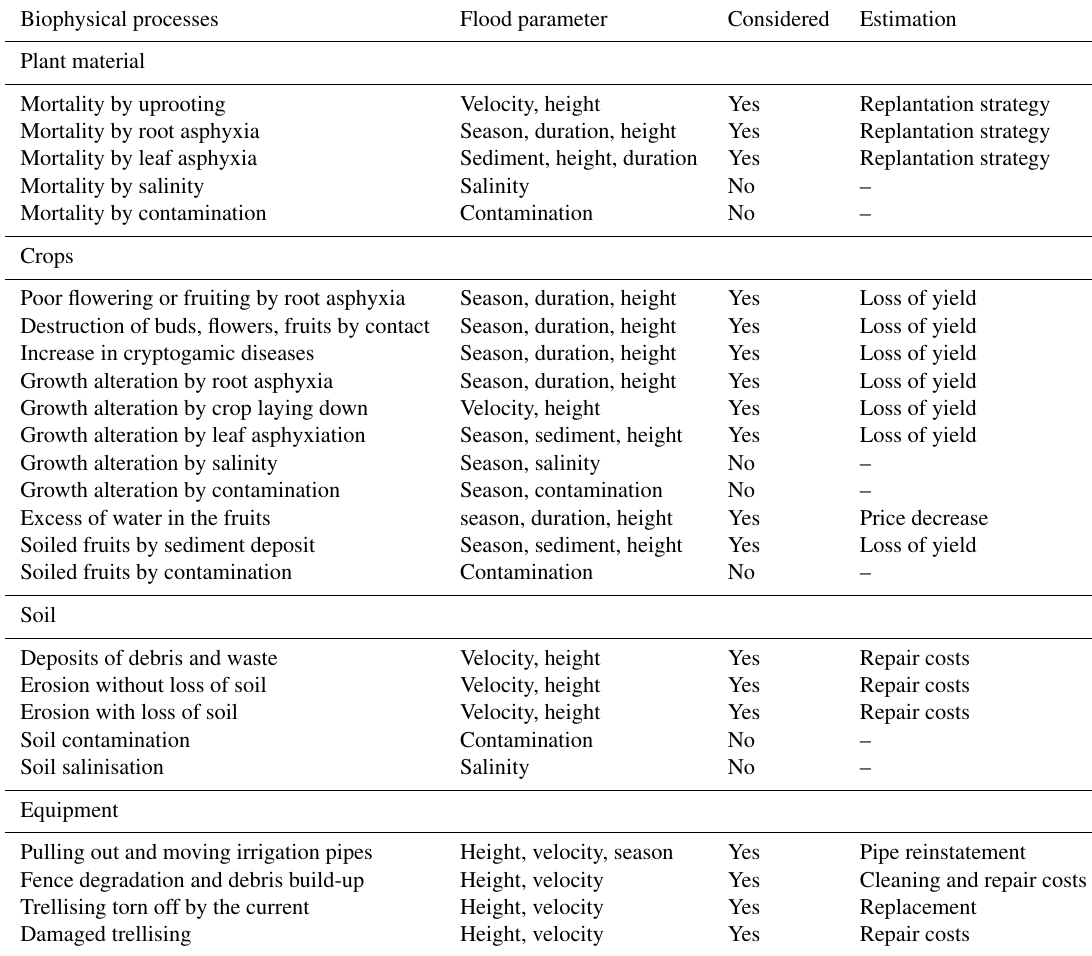
Table 2. Biophysical processes considered or not in the national flood damage functions produced with floodam.agri. Biophysical